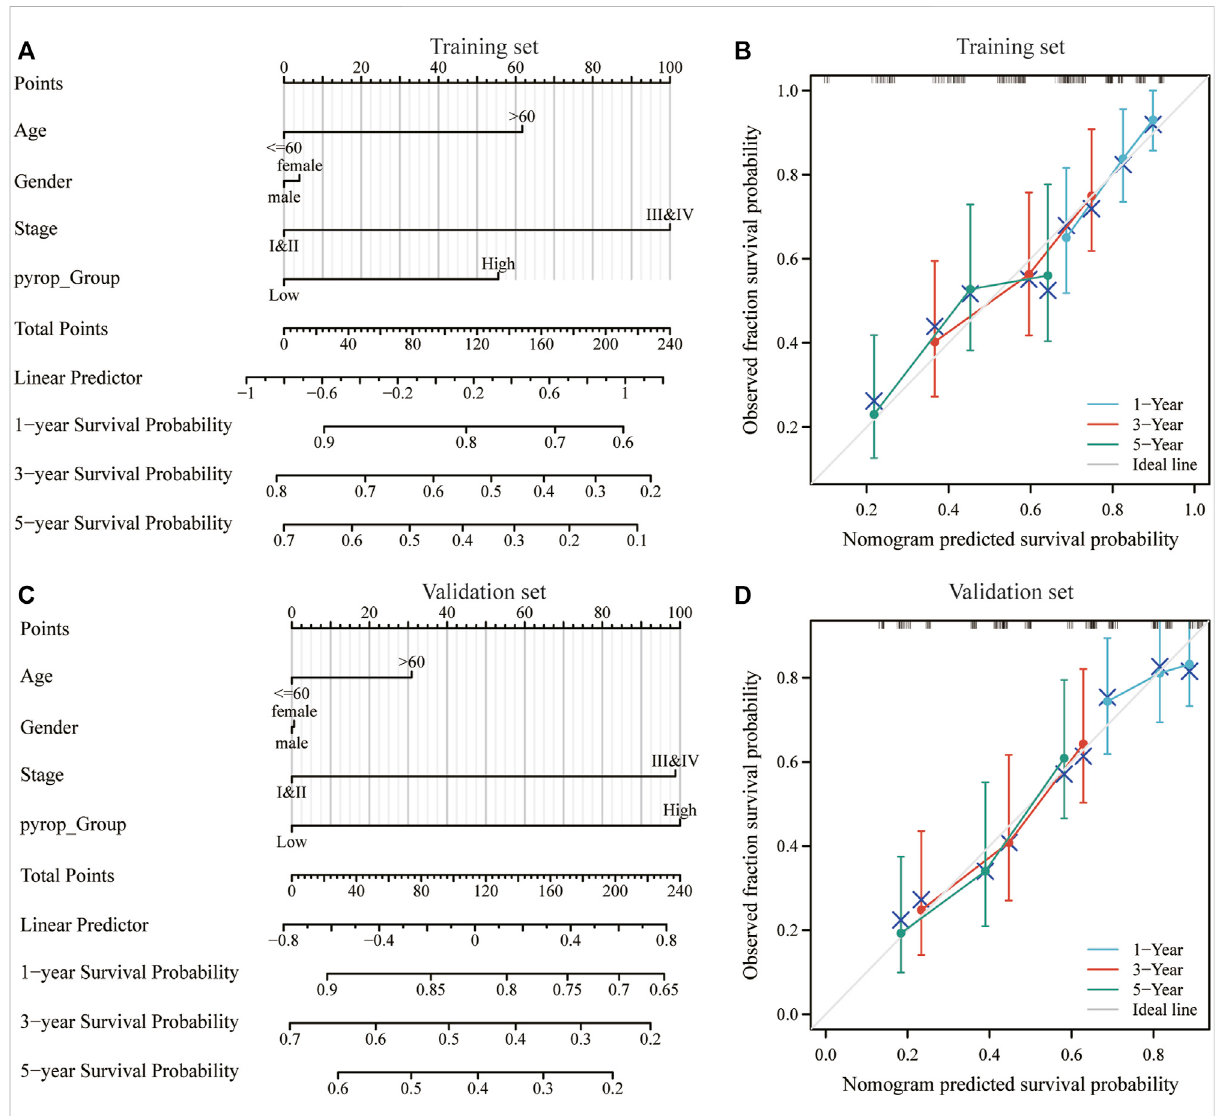
FIGURE 7 Effect of pyroptosis scoring on the prognosis of ESCC patients. (A) Nomogram model included the pyroptosis scoring in the training set. (B) Calibration curves at 1-year, 3-year, and 5-year in the training set. (C) Nomogram model included the pyroptosis scoring in the validation set. (D) Calibration curves at 1-year, 3-year, and 5-year in the validation set. * p < .05; ** p < .01; *** p <